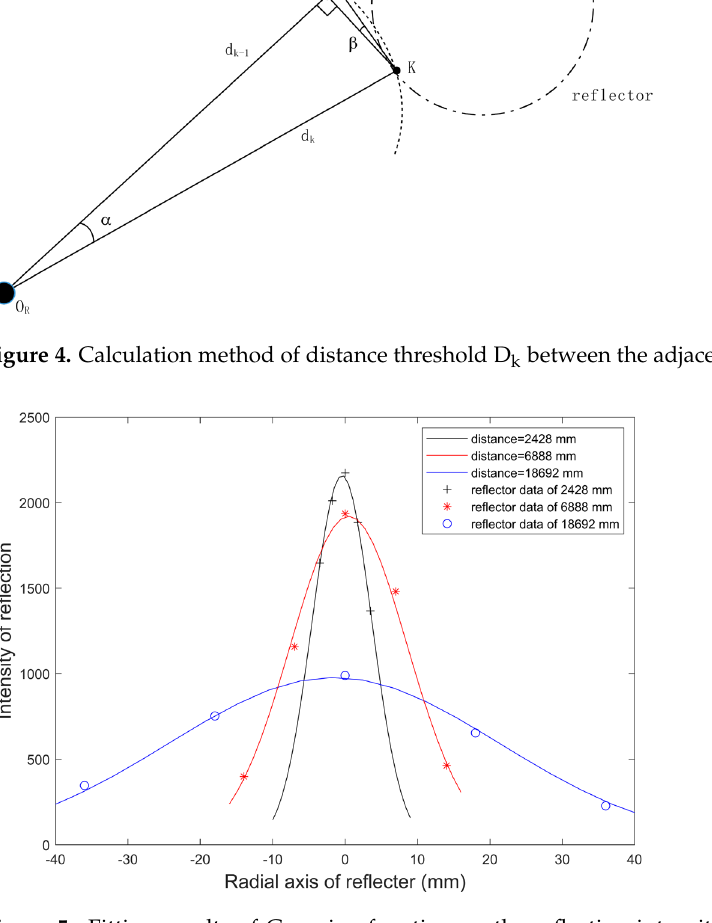
Figure 5. Fitting results of Gaussian function on the reflection intensity of the reflector data at different distances.